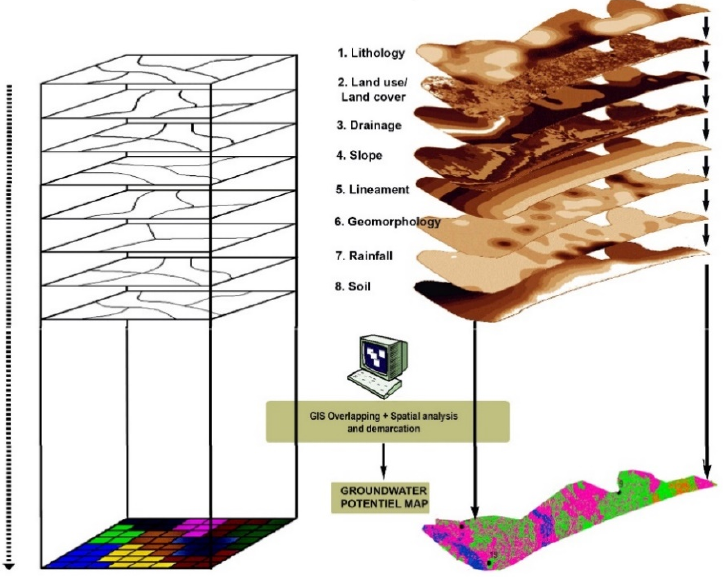
Figure 6. A schematic of thematic layer overlay analysis using geographic information system (GIS) to demarcate groundwater recharge potential zones.